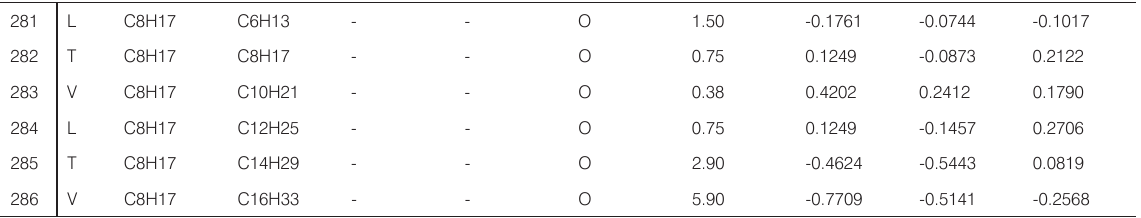
Table 1S continued. Experimental and predicted logarithms of reciprocal of the minimal inhibitory concentrations, log 1/MIC along with the errors between those two values.